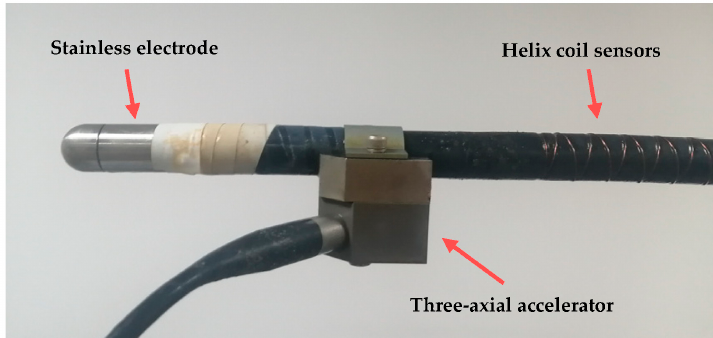
Figure 10. Improved experimental section of the towed antenna.